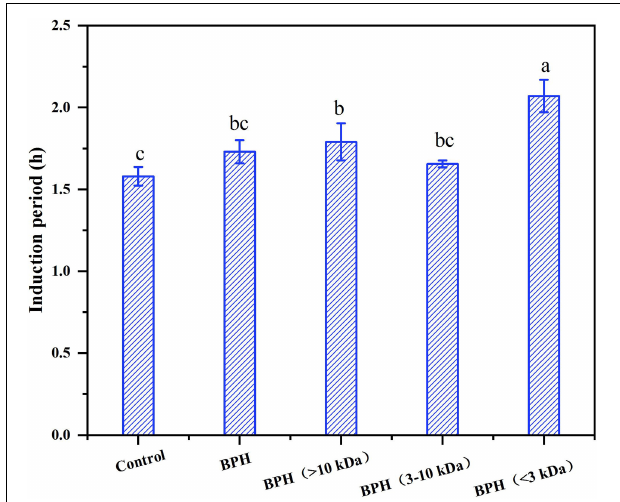
FIGURE 4 | The induction period (IP) of sunflower oil with hydrolysates. Different letters indicate the significant difference ( P < 0.05).